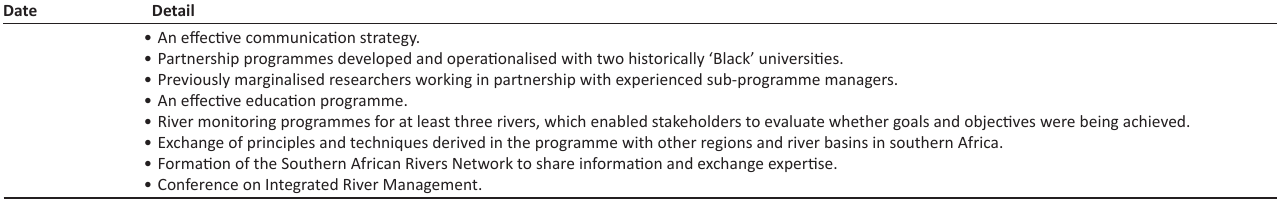
TABLE 1 (Continues...): Timeline of the Kruger National Park Rivers Research Programme outlining goals and focus (from Breen, C., Dent, M., Jaganyi, J., Madikizela, B., Maganbeharie, J., Ndlovu, J., et al ., 2000, ‘The Kruger National Park Rivers Research Programme’, Final report, Water Research Commission, Pretoria; O’Keeffe, J.